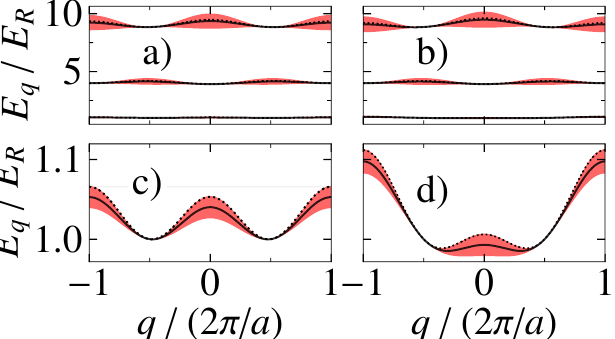
Figure 4: The first three Bloch bands with s = 1,2,3 [ parts a),b) ] and the first Bloch band with s = 1 [ parts c),d) ] in the expanded 1BZ. The plots in parts a),c) / Ω = 0.1, and and b),d) are made for α = 0 and α = 15 ◦ , respectively, with ε = Ω p c Ω = 2000 E , Γ = 1000 E and ∆ = Ω . In each band s = 1,2,3, solid lines cor- p R R p = E (cid:48) + iE (cid:48)(cid:48) respond to the real part E (cid:48) of the complex eigenvalues E , while q , s q , s q , s q , s red areas indicate the magnified widths of the dispersion lines represented by a), b) 40 E (cid:48)(cid:48) and c), d) 8 E (cid:48)(cid:48) . Dotted lines show the energy dispersions obtained from the q , s q , s adiabatic Hamiltonian